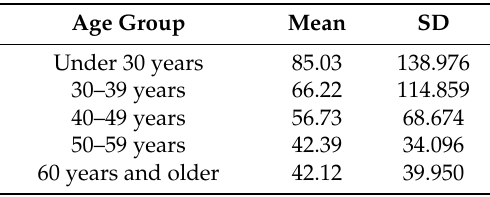
Table 11. Time spent reading per article by age